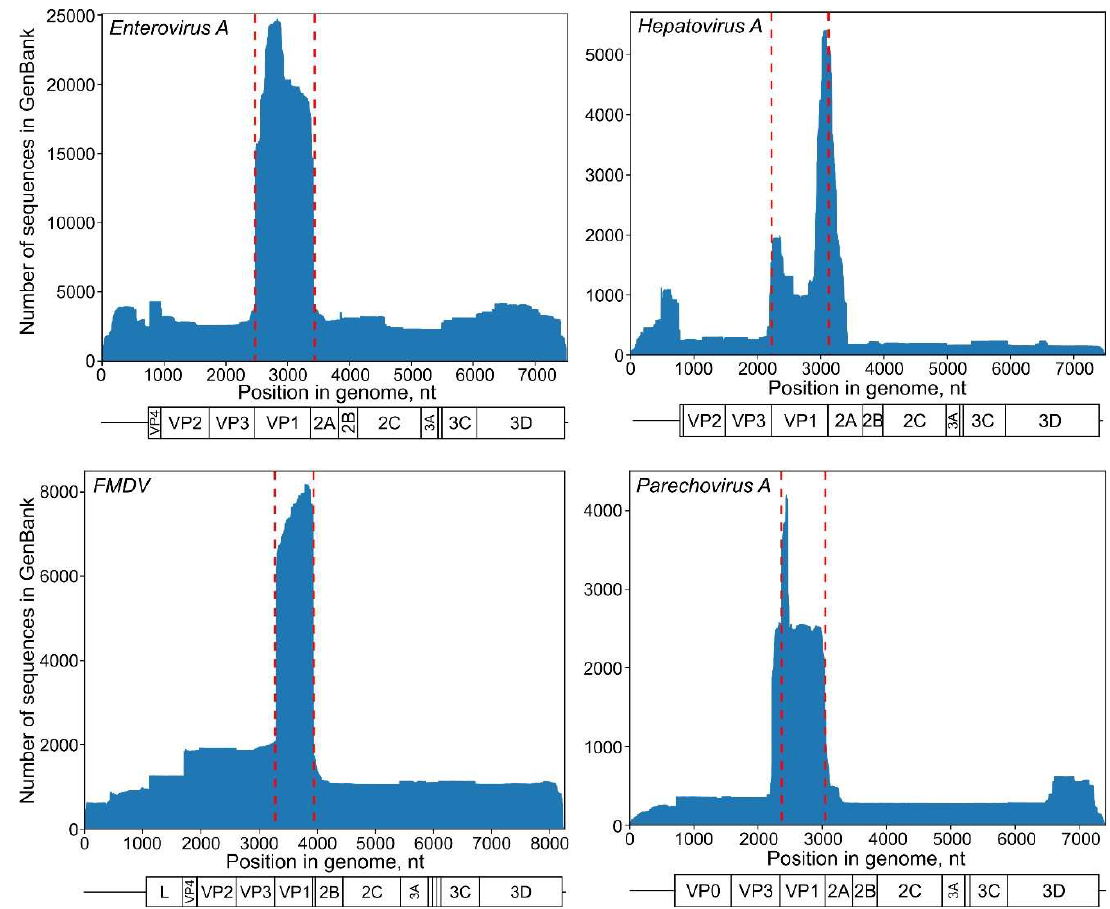
Figure 2. The distribution of genome fragments deposited in GenBank as of July 2019 along the genome in Enterovirus A , Foot-and-mouth disease virus (FMDV) , Hepatovirus A , and Parechovirus A . The y-axis indicates the number of sequences for each genome position shown on the x -axis. Dashed red lines indicate the position of the VP1 protein-encoding sequence.